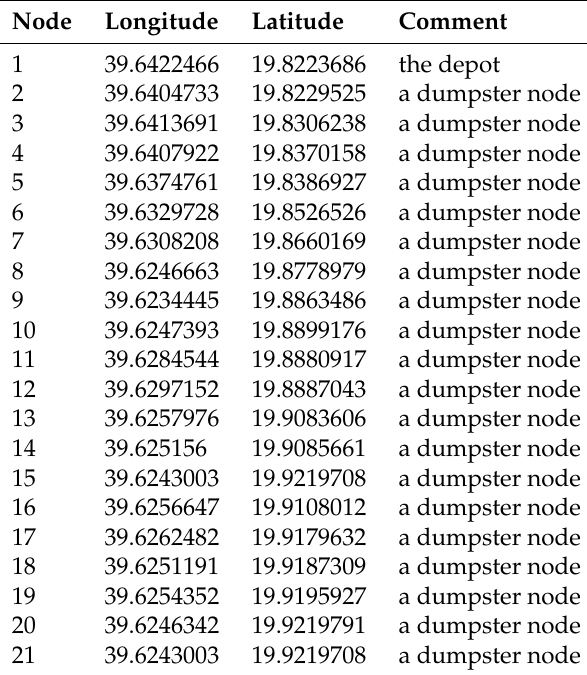
Table 4. Practical case’s